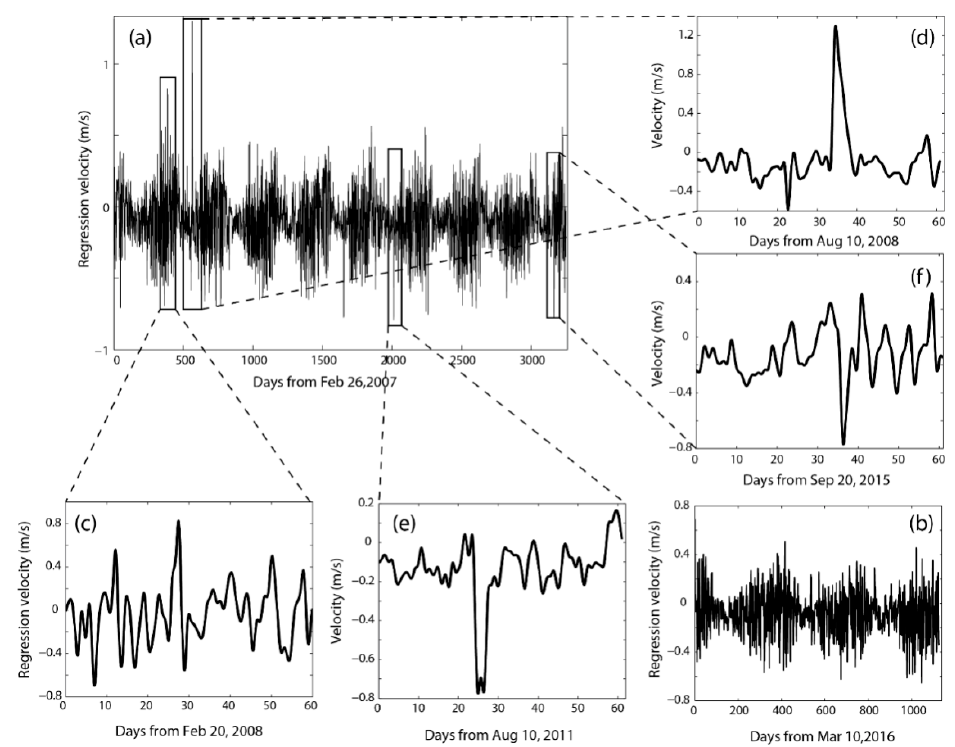
Figure 11. Regression curve: ( a ) Feb 26, 2007 to Jan 20, 2016, ( b ) Mar 10, 2016 to Apr 10, 2019; ( c ) zoomed-in view for the selected warm front; ( d ) zoomed-in view for Hurricane Ike; ( e ) zoomed-in view for Tropical Storm Lee; and ( f ) zoomed-in view for the selected cold front. J. Mar. Sci. Eng. 2020 , 8 , x FOR PEER REVIEW